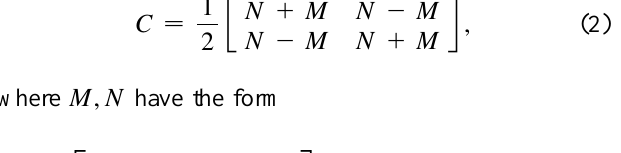
TABLE I. Bunch parameters for linear collider projects in comparison with typical free electron laser (FEL) rf gun pa- rameters. Here and in the following, ´ denotes the normalized